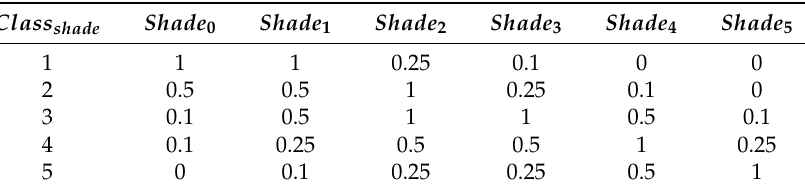
Table A10. NECN light establishment parameters.